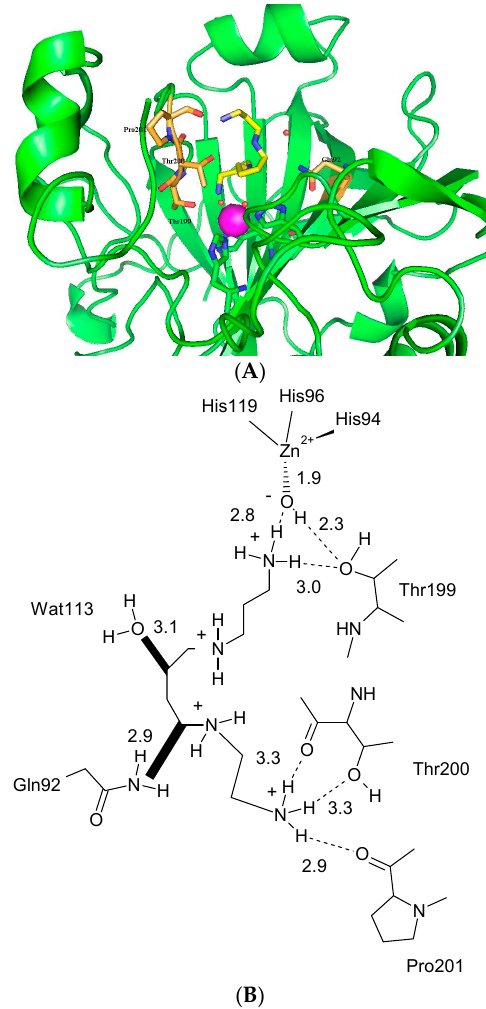
Figure 7. ( A ) Detailed interactions in which spermine (in yellow) participates when bound to the hCA II active site. The zinc ion (violet sphere), the water molecule coordinated to it (small red sphere), and its three protein ligands (His94, 96, and 119, in green), as well as amino acids involved in the binding of spermine 3 (Thr199, Thr200, Pro201 and Gln92, in gold), are also shown. The protein scaffold is in green (ribbon diagram); ( B ) Schematic representation of interactions in which spermine 3 (as tetracation) participates when bound to the hCA II active site. Figures represent distances (in Å). Hydrogen bonds are represented as dashed lines. In bold two clashes are shown involving some carbon atoms (C5 and C7) of the spermine 3 scaffold with a water molecule (Wat113) and Gln92. The non-protein zinc ligand is represented as a hydroxide ion, which should be the preponderant species at the pH at which the experiments were done (7.5). PDB accession code: 3 KWA [10].